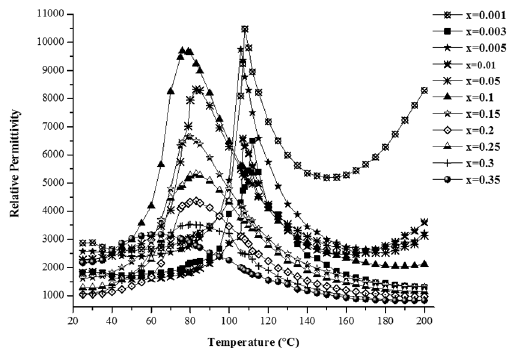
Figure 4: Relative permittivity at 1 kHz as a function of temperature capacitors prepared from